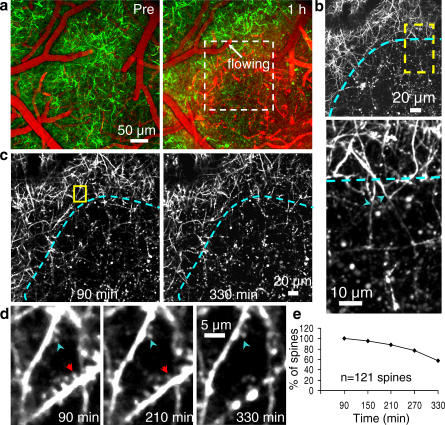
Localized Stroke Damage to Dendrites and Maintenance of Stable and Sharp Borders for Dendritic Damage(A) Low-magnification image of the vascular and dendritic structure before and 1 h after photoactivation of RB.(B) Image showing localized stroke damage to dendrites. Top panel, a magnified view of the white boxed region in (A) showing dendritic structure (a substack Z-projection) 90 min after photoactivation of RB; bottom panel, a magnified view of the yellow-boxed region in top panel showing individual dendrites (arrowheads) that were more damaged and beaded when they projected into an ischemic zone.(C) A magnified view of the yellow-boxed region in (A) showing dendritic structure (a sub-stack Z-projection) at 90 min and 330 min after RB photoactivation. Note the sharp border (blue line) indicates a sharp transition from relatively normal dendritic structure to beaded and swollen structure.(D) Further magnified view (yellow box in [C]) showing a stable spine (blue arrowhead) and a lost spine (red arrowhead) 5.5 h after stroke near the border region.(E) Spine number expressed as a percentage of the number present at the timepoint 90 min after RB photoactivation (it took time to locate the stroke edge, and data prior to 90 min were not obtained for this region).